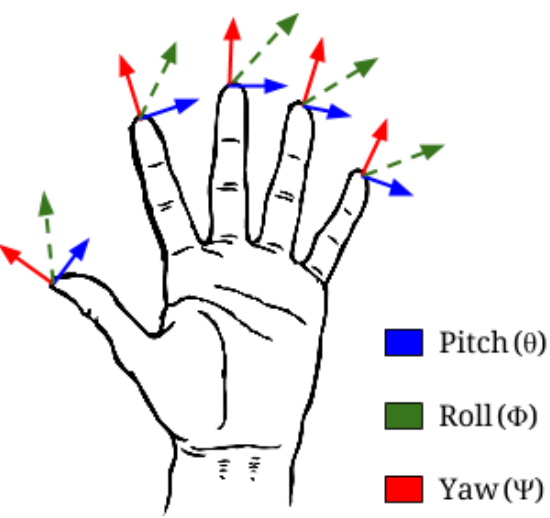
Figure 4. Euler Angle representation of each finger for measuring the absolute orientation. The IMUs are placed on the finger tip of the glove and track the hand